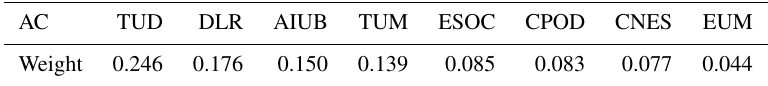
Table 4. ACs sorted according to the highest weights in average. AC TUD DLR AIUB TUM ESOC CPOD CNES Weight 0.246